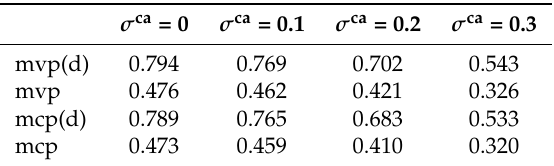
Table 5. Emissions rates for minimum variance and minimum CVaRD portfolios (tCO 2 /MWh) in both the fully dispatchable and in the integrated case. (d) stands for dispatchable. σ ca = 0 σ ca = 0.1 σ ca =